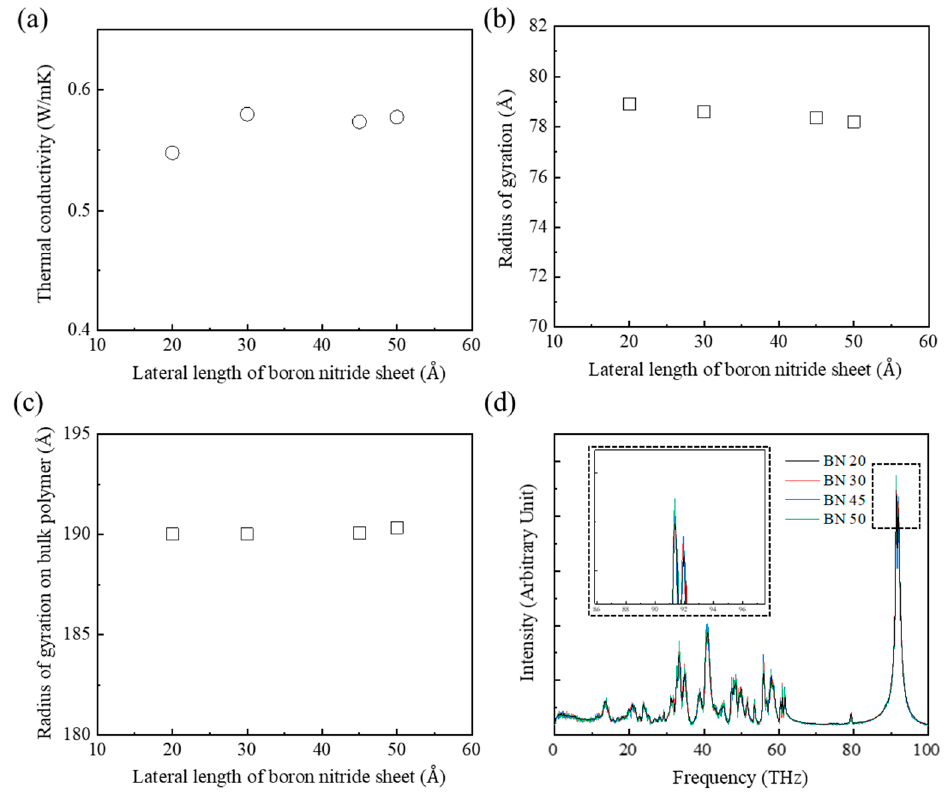
Figure 7. Thermal transport according to the lateral length of square BN sheets in the PEEK/BN composites: ( a ) thermal conductivities, ( b ) radius of gyration, ( c ) radius of gyration on the bulk polymer, and ( d ) PDOS of composites.